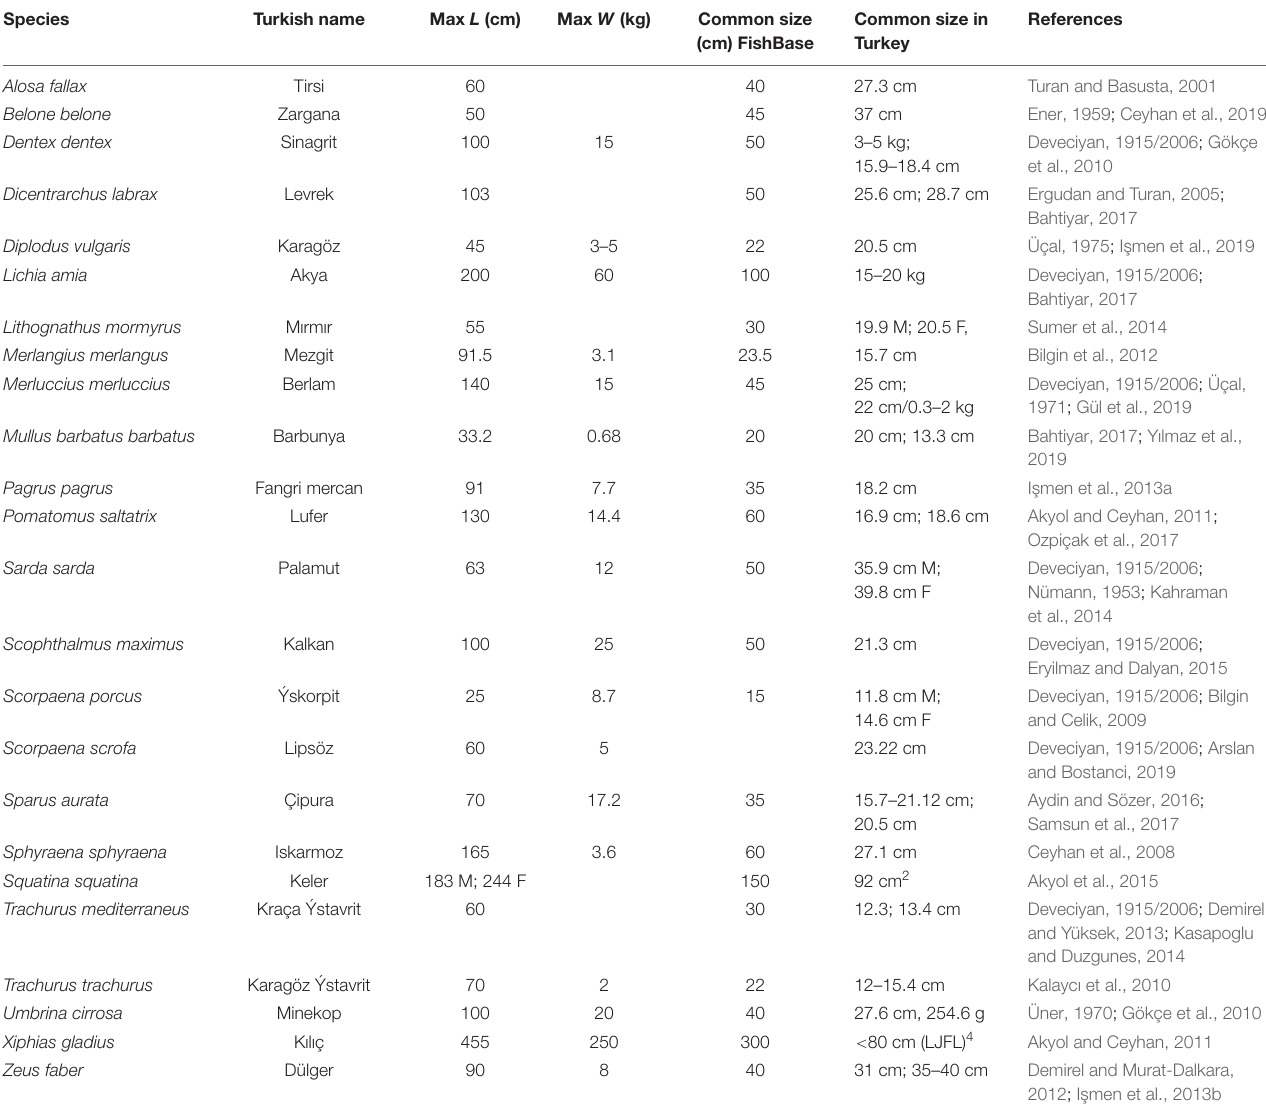
TABLE 3 | Data on size reduction of fish taxa exploited in the Turkish Black Sea and Marmara Seas by comparing their maximum length or weights (based on historical sources), to common lengths (reported in FishBase), to current common sizes in Turkish waters (using Black Sea and Marmara Sea records where possible); FL = fork length; M = Male; and F = Female.